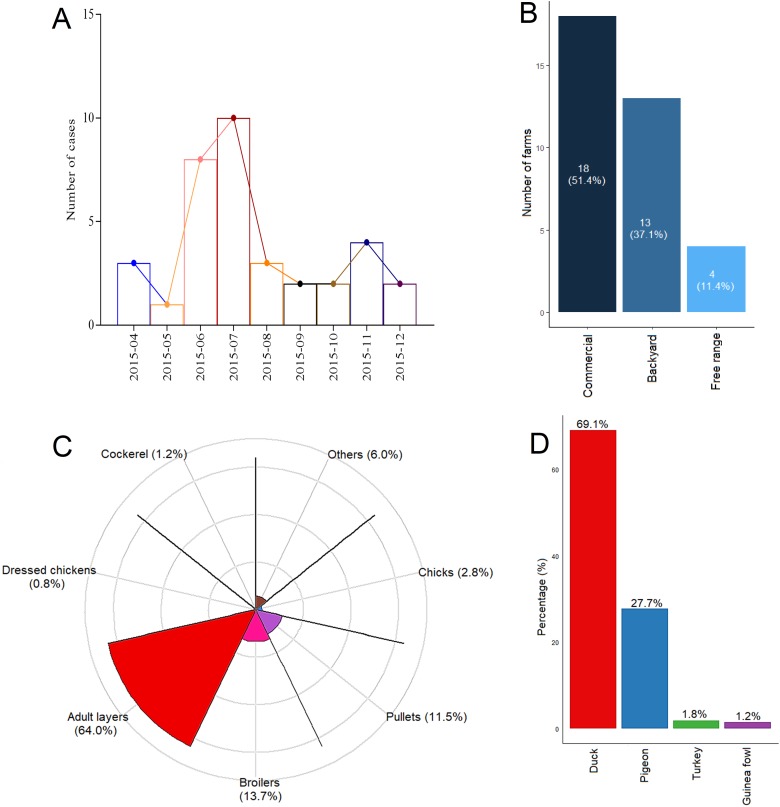
Epicurve of outbreaks and descriptive statistics of the type of farm and birds affected. (a) Epicurve showing the number of outbreaks per month. (b) Distribution of the type of farm affected. (c) Avian influenza losses by the type of bird (percentages were calculated using the total number of birds destroyed). (d) Avian influenza losses for birds other than domestic fowl (percentages were calculated using the total number of birds destroyed other than domestic fowl).